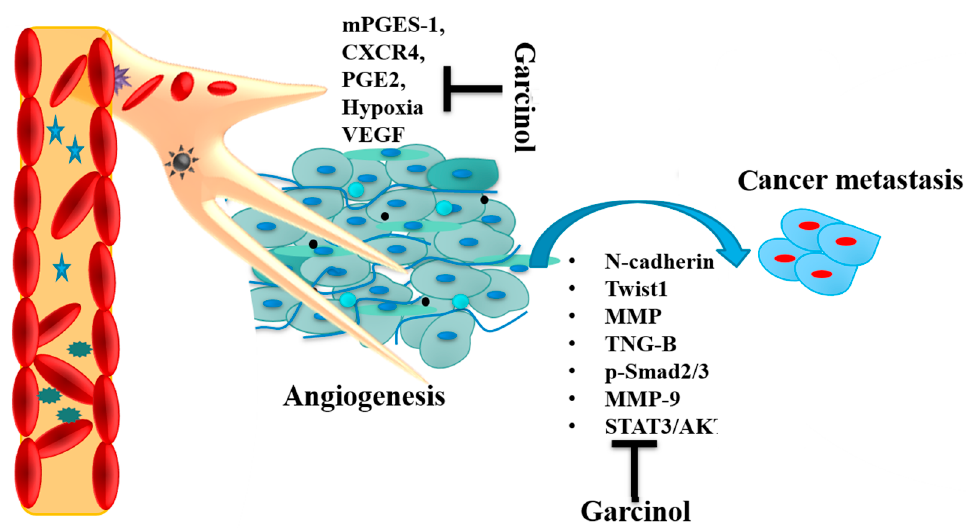
Figure 5. Anti-angiogenic and anti-metastatic action of garcinol. Microsomal prostaglandin E synthase-1 (mPGES-1), prostaglandin E synthase 2 (PGE2), hypoxia inducible factor-1 alpha (HIF-1 α ), C-X-C chemokine receptor type 4 (CXCR4), vascular endothelial growth factor (VEGF), matrix metalloproteinases (MMP-9), AKT serine / threonine kinase (Akt), signal transducer and activator of transcription 3 (STAT3), twist-related protein 1 (Twist1).